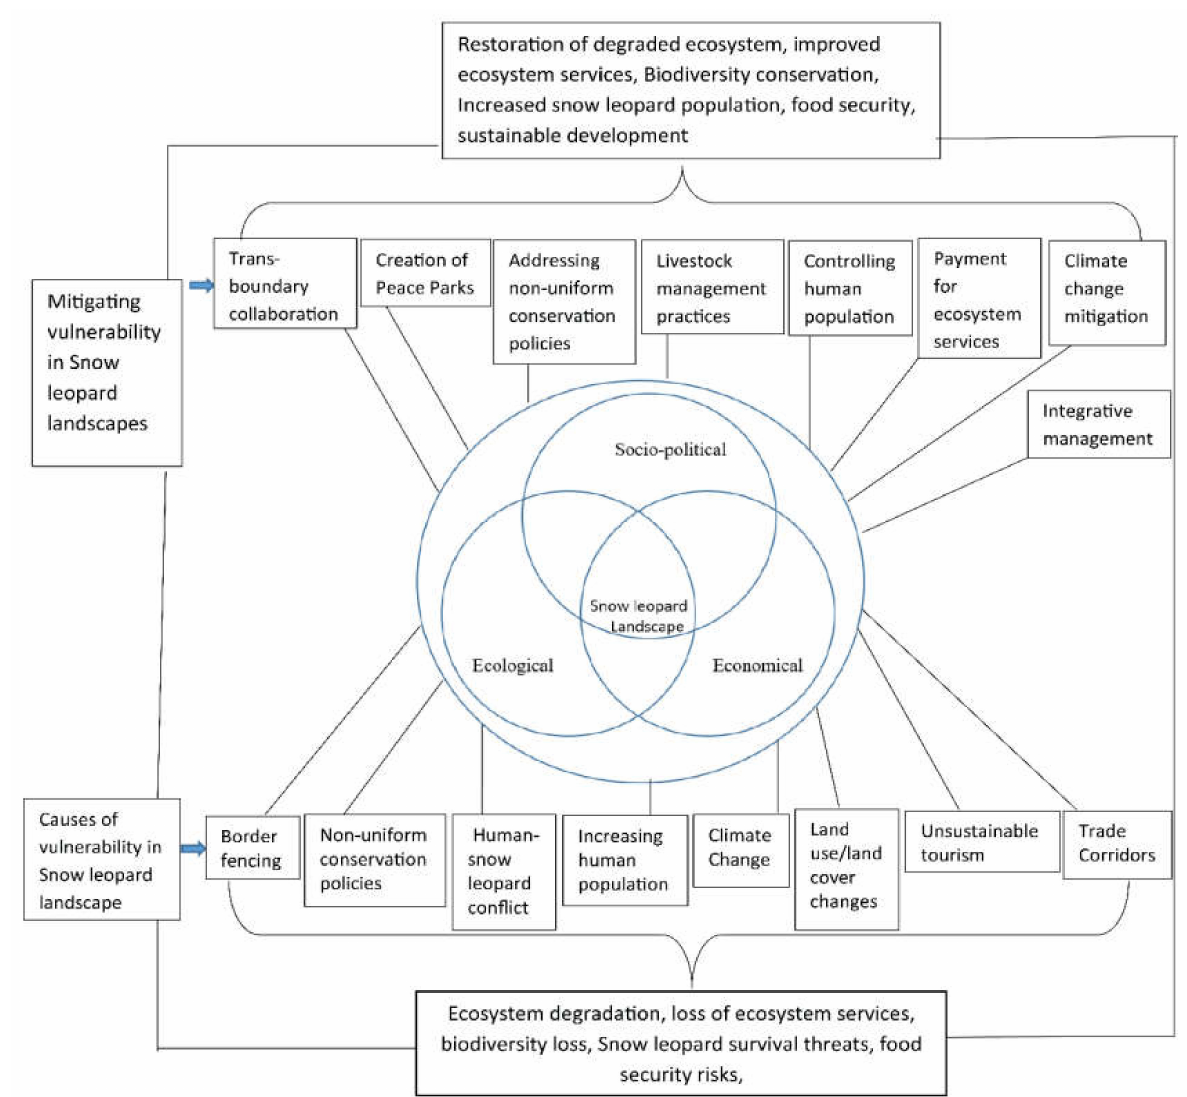
Figure 3. The socio-ecological system of the snow leopard habitat region in the framework of vulnerability and management